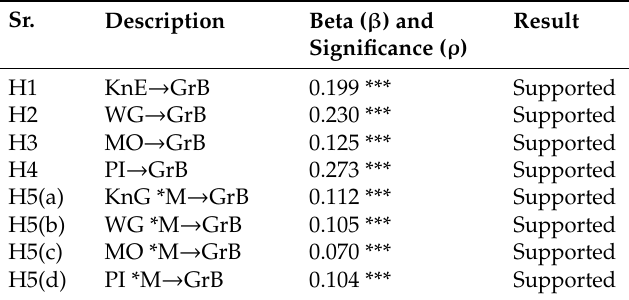
Table 6. Parameter estimation for proposed